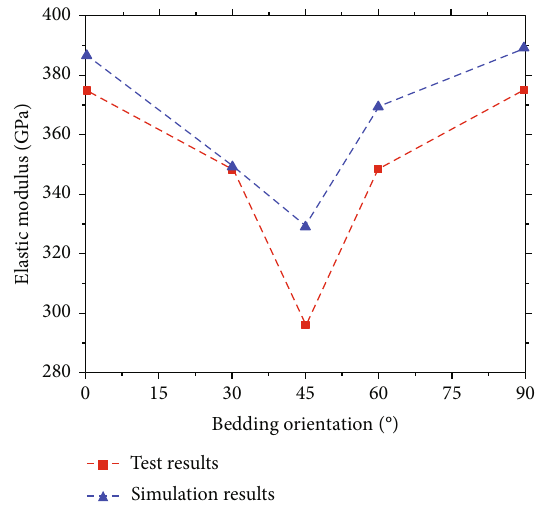
Figure 18: The contrast between simulation and test results on the variation of shale strength over β